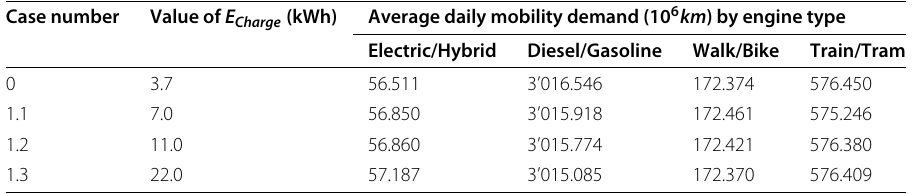
Table 4 Result of daily average mobility demand (10 6 km ) by engine type in scenarios of charging